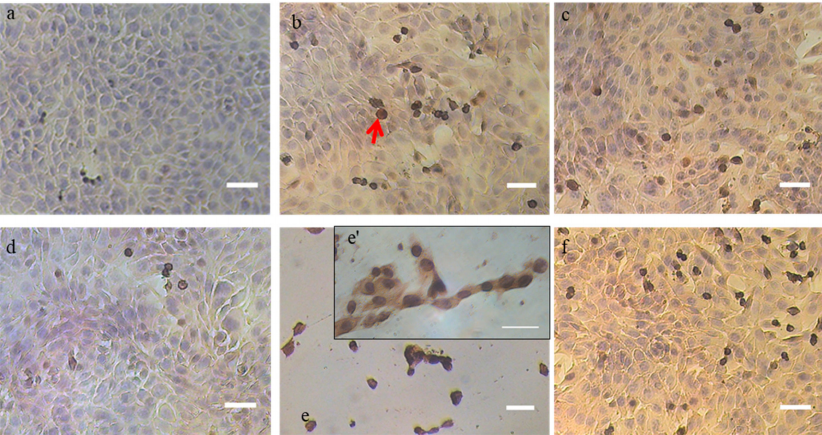
Figure 2. Detection of apoptotic cells in situ by DNA fragmentation through TUNEL assay. The apoptotic cells are stained dark brown (red arrows) after counterstaining with hematoxylin. ( a ) untreated cells at 10X magnification, ( b ) DNase-treated cells for 20 min at 10U (positive control) at 10X magnification, ( c ) 0.5 mg / mL DSS treated cells after 18 h at 10X magnification, ( d ) 0.5 mg / mL DSC-treated cells after 18 h at 10X magnification, ( e and e’ ) 0.5 mg / mL DSS treated cells after 24 h observed at 10X and 40X magnification, respectively, ( f ) 0.5 mg / mL DSC-treated cells after 24 h at 10X magnification. Note: Scale bar = 50 µ